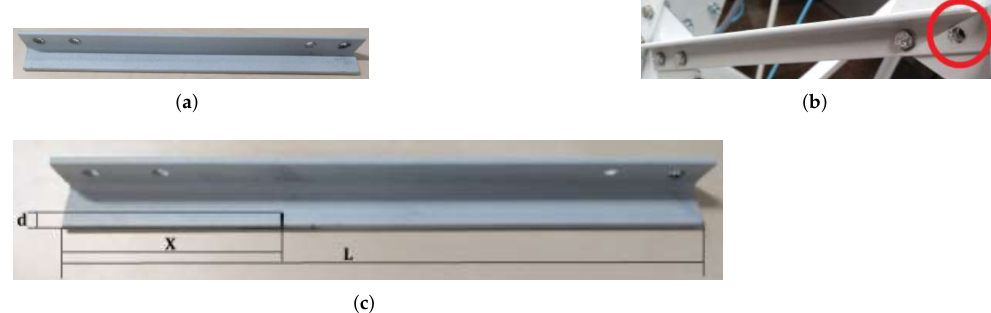
Figure 3. Different structural states studied: ( a ) replica bar (Healthy); ( b ) unlocked bolt; ( c ) details of the crack damage. L is the bar length, d = 5 mm is the crack size, and X = L/3 specifies the position of the crack.